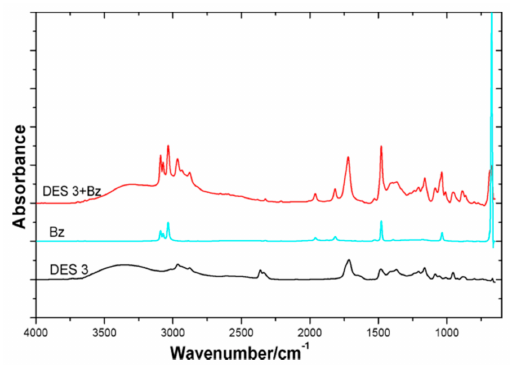
Figure 14. FT-IR spectra of ( a ) DES3 and benzene, ( b ) benzene, ( c ) DES3 (DES3 = 0.1 (molar concen-